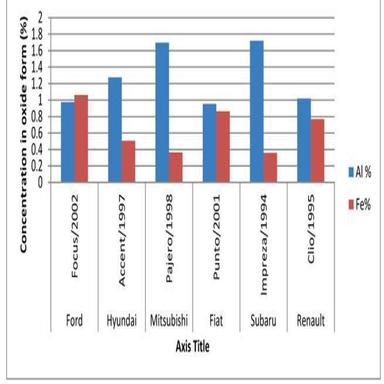
Bar plot showing the relation between brand wise average concentrations of Al and Fe oxide.